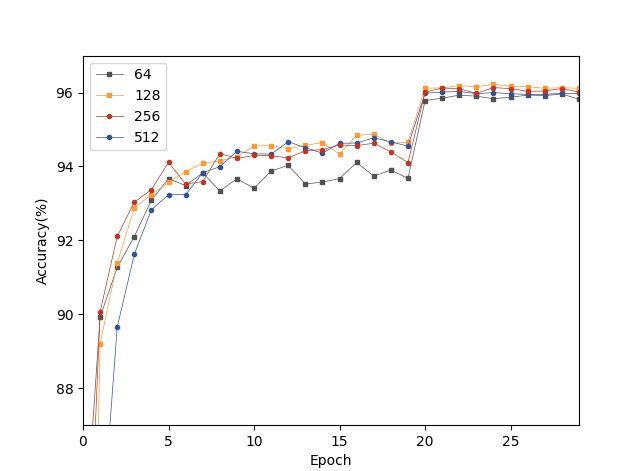
Figure 6. The average recognition accuracy of different batchsizes on the IAHCC-UCAS2016 varied with the training